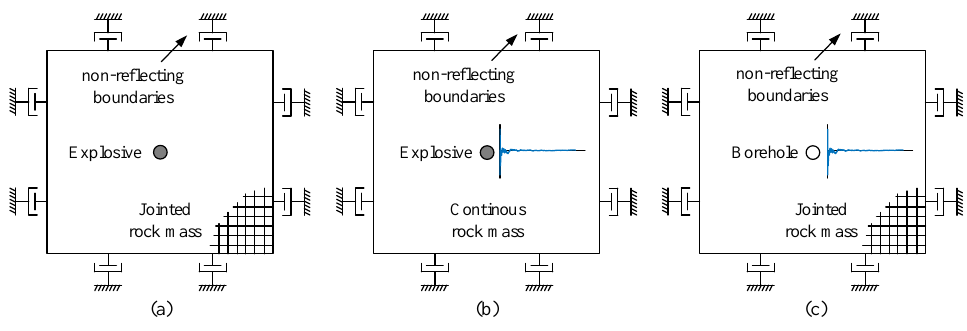
Figure 5. Coupled method illustrating the ( a ) physical model of explosion in jointed rock mass, ( b ) explosion history obtained via LS-DYNA, and ( c ) input of converted explosion history for UDEC simulation.